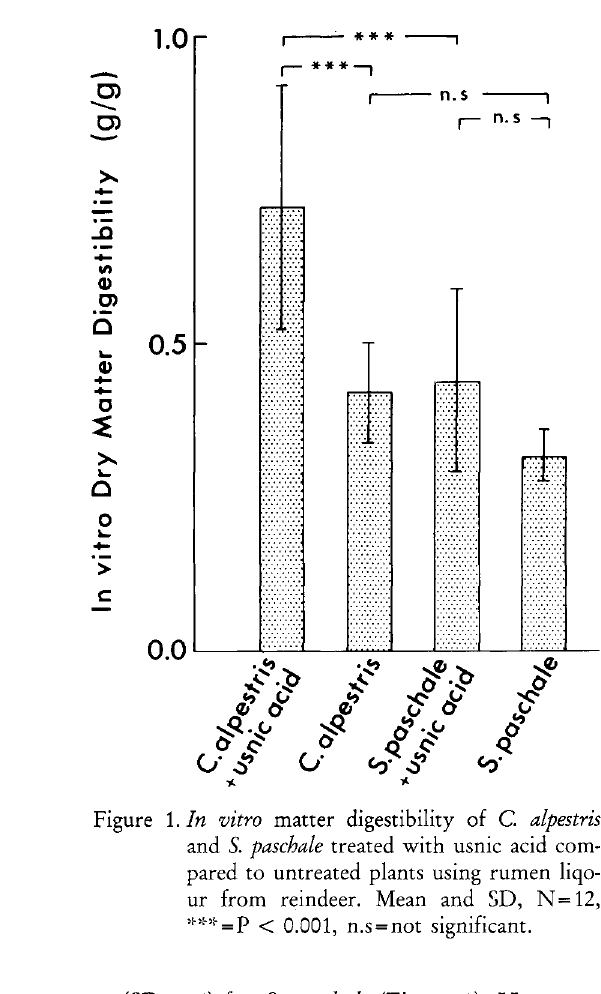
Figure 1. In vitro matter digestibility of C alpestris and 5. paschale treated with usnic acid com pared to untreated plants using rumen liqo- ur from reindeer. Mean and SD, N=12, *** = P < 0.001, n.s = not